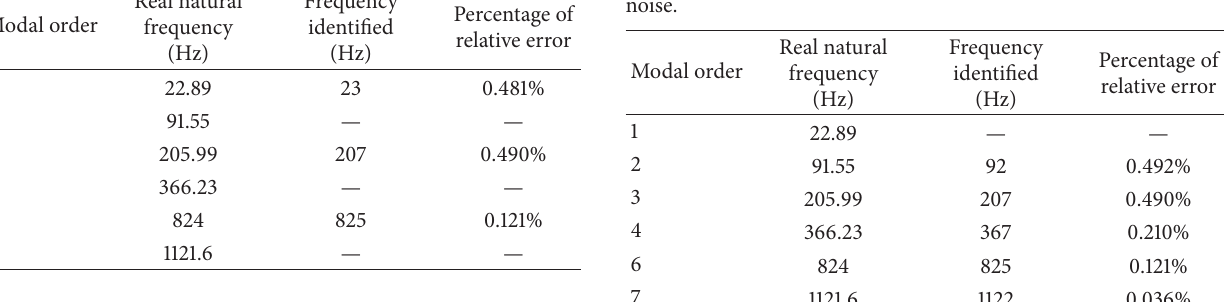
Table 14: The convergence times and MAC value of modal shapes when observed signals are with measurement noise.